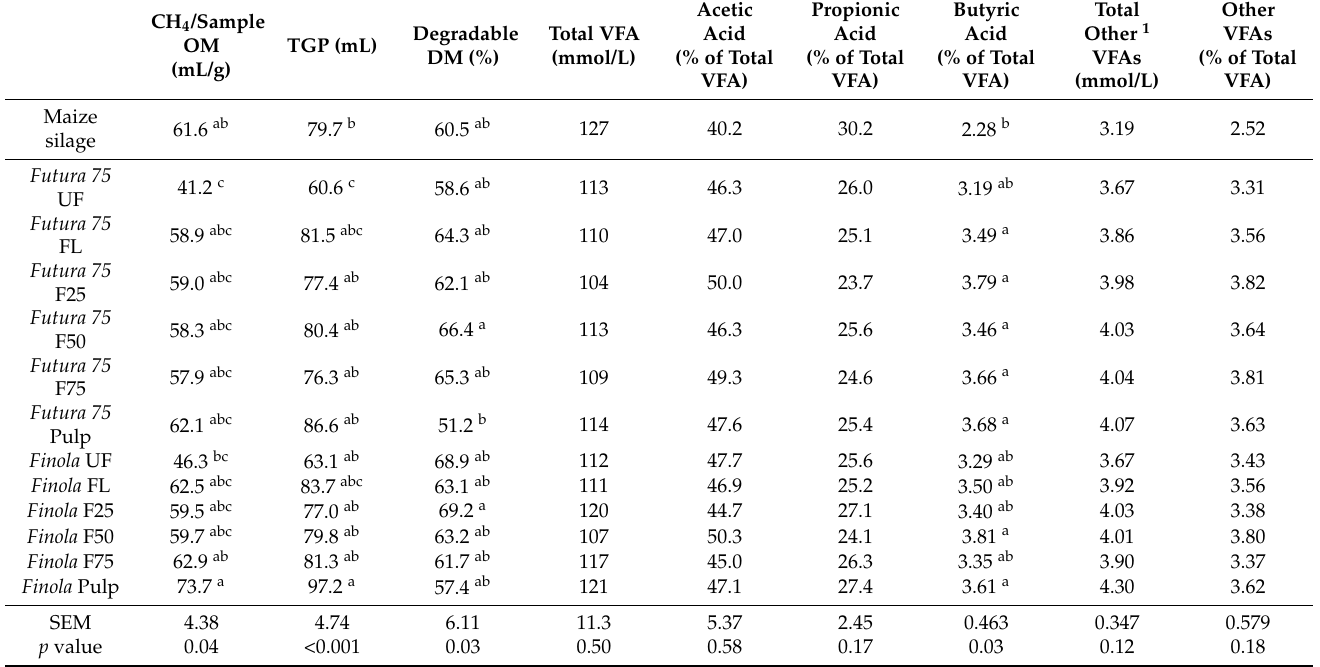
Table 1. Effects of addition of hemp extract (UF), flow-through (FL), fractions eluted with 25% acetonitrile (ACN) (F25), 50% ACN (F50), 75% ACN (F75), and pulp to a standard feed (0.5 g maize silage) on dry matter (DM) degradability, total gas production (TGP), methane (CH 4 ) production per sample organic matter (OM), and volatile fatty acid (VFA) concentrations in the incubation media after 48 h incubation in an in vitro system simulating rumen fermentation. Two varieties Cannabis sativa L. Futura 75 and Cannabis sativa L. Finola were used in this